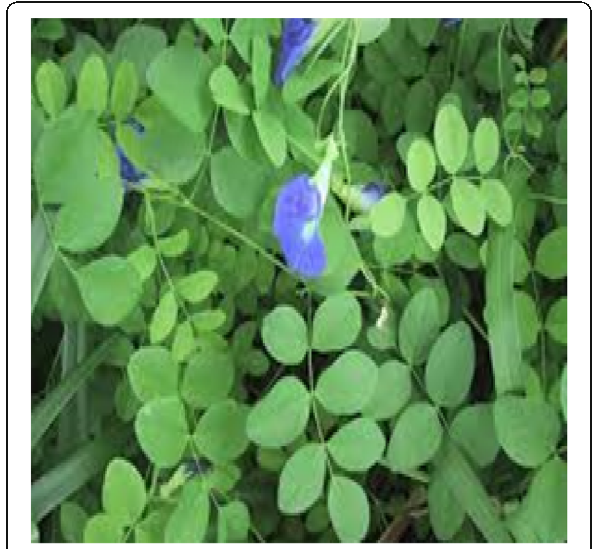
Fig. 6 Clitoria ternatea . This endangered species belongs to the plant family Leguminosae (Fabaceae or Papilionaceae) (Copy source Jacob Thomas